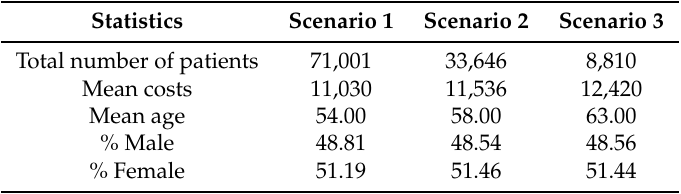
Table 2. Statistics of patients’ records in each